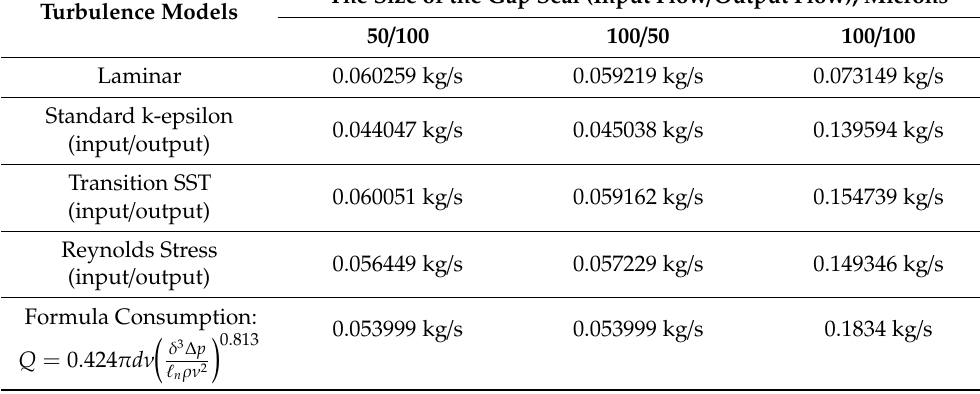
Table 4. Volume flow through a gap defined by di ff erent flow models for di ff erent sizes of gap seals for turbulent flow